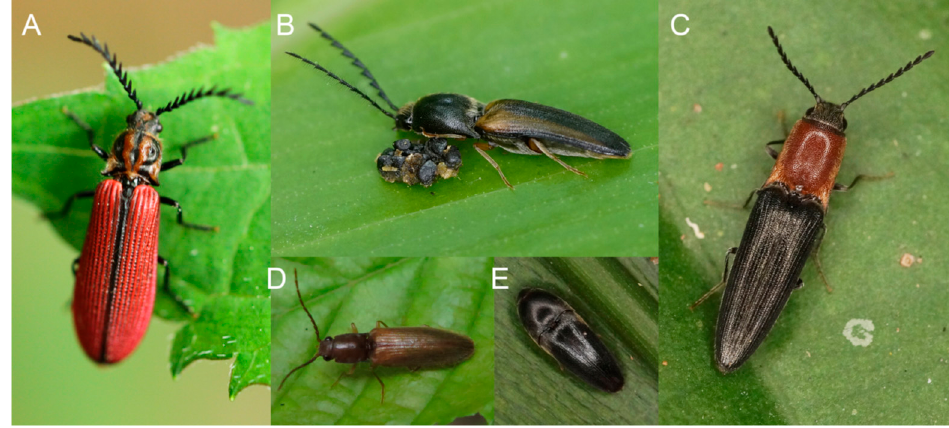
Figure 1. Clicking elateroids in nature. ( A – D ) click beetles, Elateridae; ( E ) false click beetle,